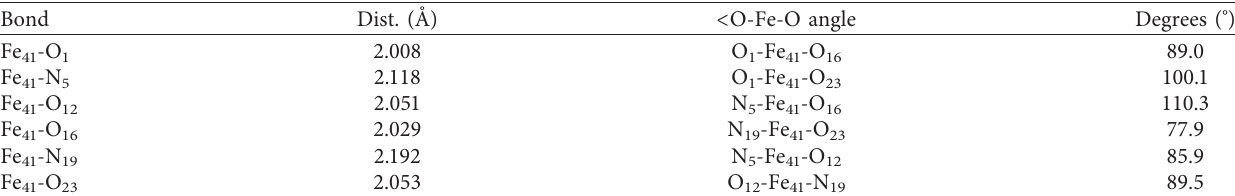
Figure 7: The optimized structures of DTPA complexed with (a) one and (c) two Fe 2+ ions and the optimized structure of BOEN complexed, (b) one (d) two Fe 2+ ions. Table 4: The bond parameters of BOEN bonded to one Fe 2+ ion.